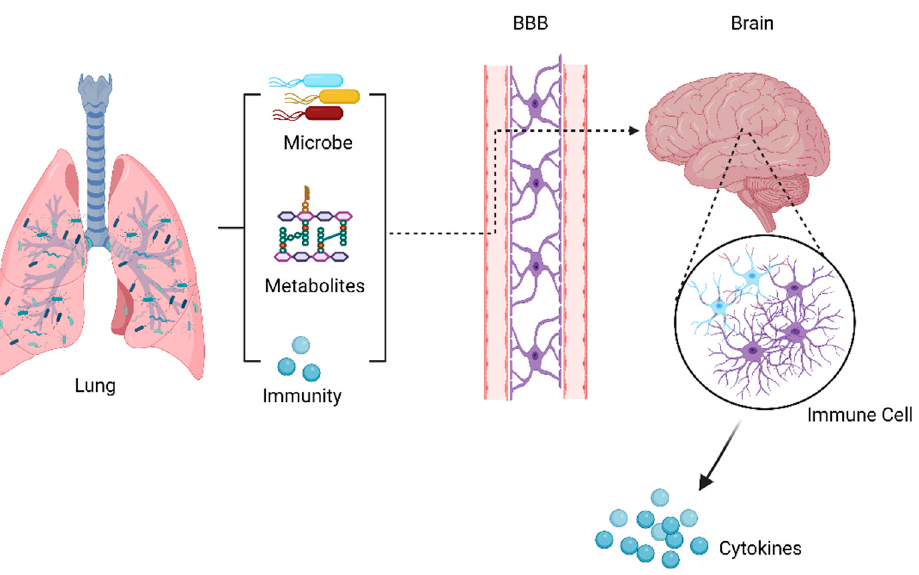
Figure 2. Possible communication pathways in the lung–brain axis. This communication between the lungs and the brain takes place through microbiota, metabolic, and immunological pathways, which may cross the BBB and reach the CNS to alter immune cells in the brain, influencing the brain disease. Author Contributions: The work presented here was carried out in collaboration between all au- thors. H.S. and Y.K. conceived and designed the review; J.-D.H. provided expertise in the design of